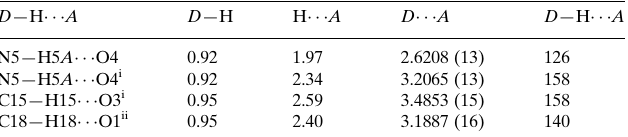
Hydrogen-bond geometry (A˚ , (cid:3)